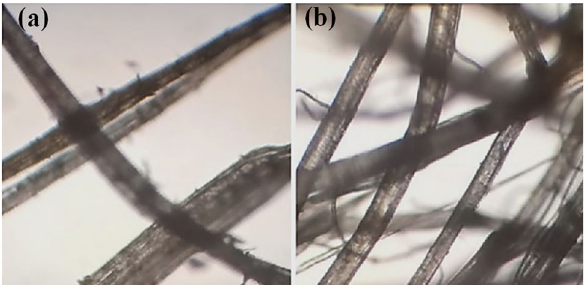
Figure 2. Representative optical microscopy images (100×) of the raw fiber ( a ) and treated cellulose fiber with the chemical softener TTAB ( b ).